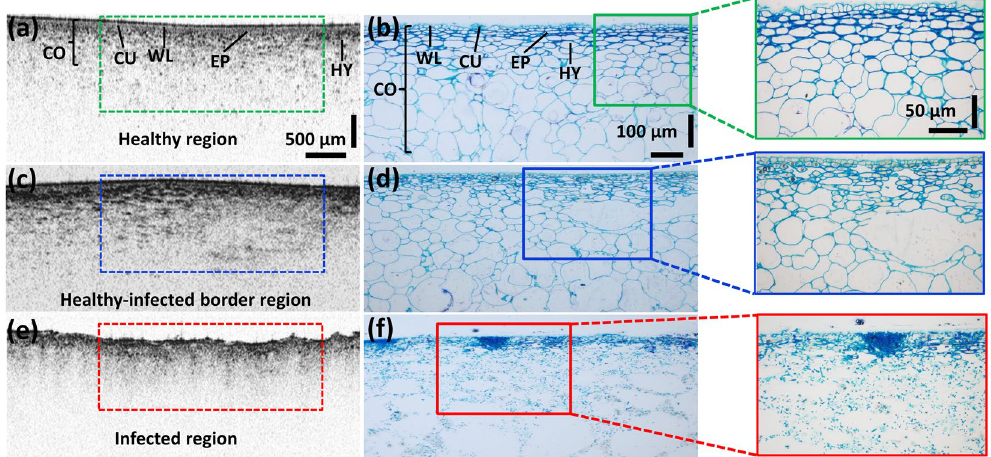
Figure 5. Histological confirmation of the 2D OCT images acquired from healthy and naturally infected fruit specimens. ( a,b ) Images representing the morphology of healthy specimens. ( c,d ) Images representing the cross-sections of a partially infected (apparently healthy) specimen. Finally, ( e,f ) represent the cross-sections of an entirely infected specimen. The zoomed version of each histological section is shown in the right